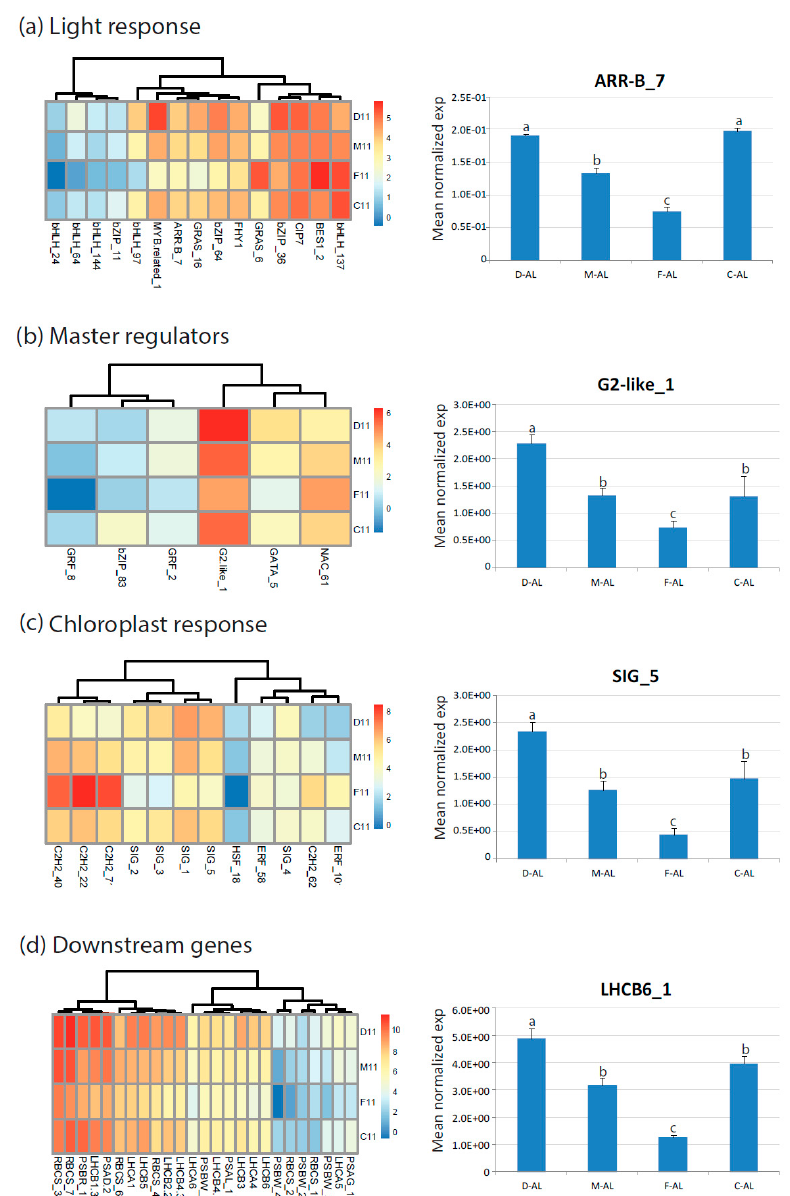
Figure 7. Heat map showing relative expression values (log2 RPKM) of genes differentially expressed in endive and escarole cultivars (year 2011) and related to photosynthesis: ( a ) Light response genes; ( b ) master regulators genes; ( c ) chloroplast response genes; and ( d ) downstream genes ( LHCB, RBC , photosystems). The expression of one gene for category was reconfirmed by qRT ‐ PCR on RNA from mature leaves (AL). D, ʹ Domari ʹ ; M, ʹ Myrna ʹ ; F, ʹ Flester ʹ ; and C, ʹ Confiance ʹ .